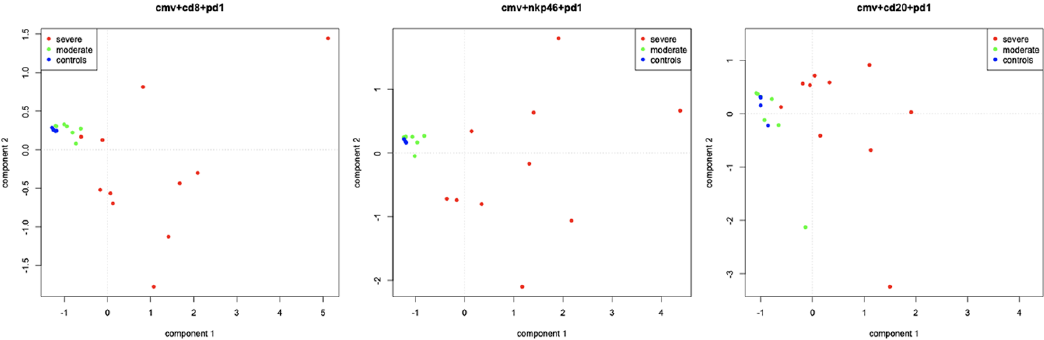
Figure 5. Principal component analysis of CD8, or NKp46, or CD20 and viral multiplication (HCMV) and PD-1 in brain lesions according to cerebral severity (A (severe) / B (moderate) / controls). Severe cases are represented by red dots, moderate cases by yellow dots, and controls by blue dots.